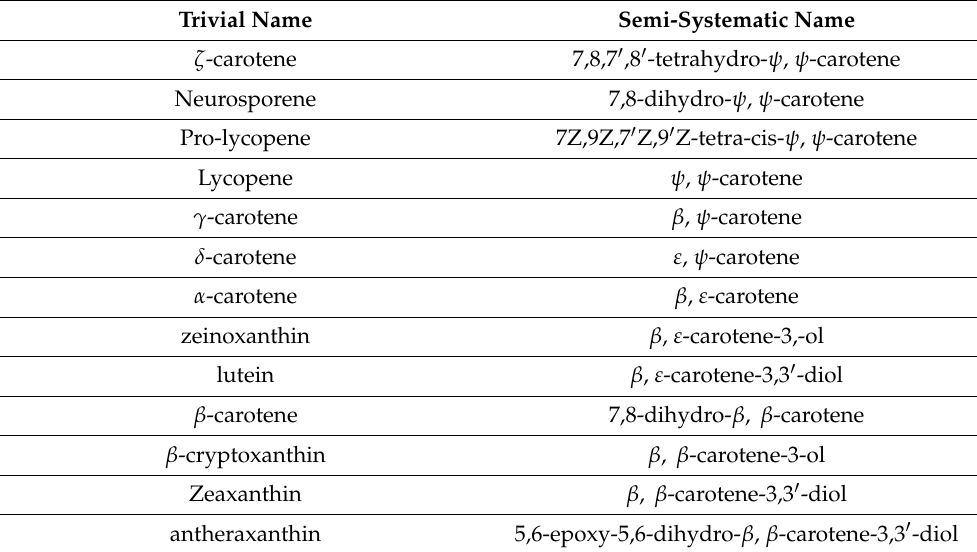
Figure 11. The working principle of dye-sensitized solar cells [172]. 4.4. Commercialization of DSSC Dye-sensitized solar cells have attracted increasing attention (cost effectiveness and ease of production) in the last few years. Research is ongoing to improve the efficiency and stability of solar cells. Technically speaking, natural dyes are inefficient and show very weak binding properties with titanium dioxide. Therefore, synthetic dye was used